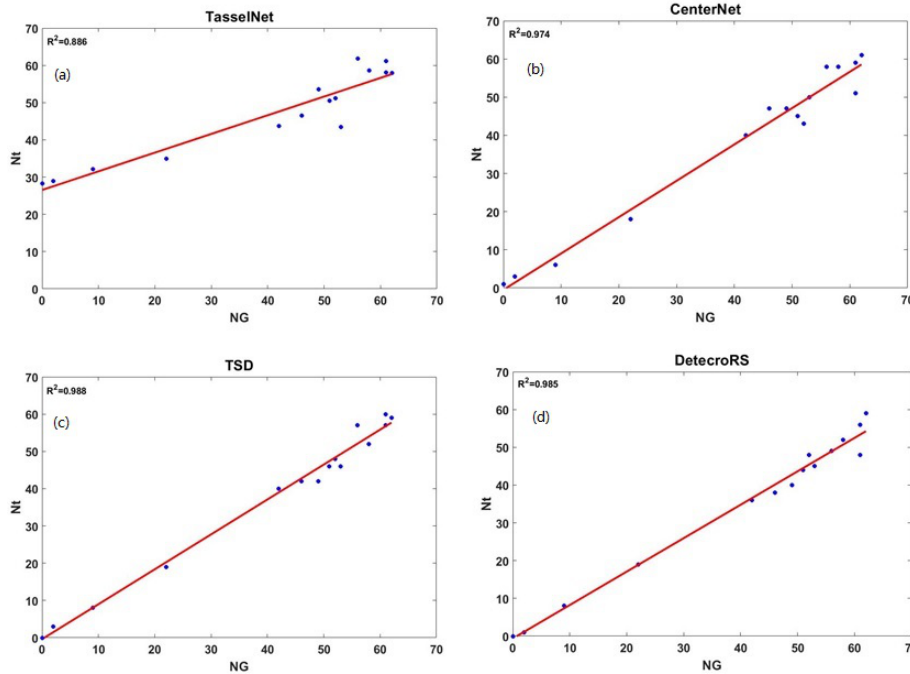
Figure 20. Linear regression plots for ( a ) TasselNetv2+. ( b ) CenterNet. ( c ) TSD. ( d )